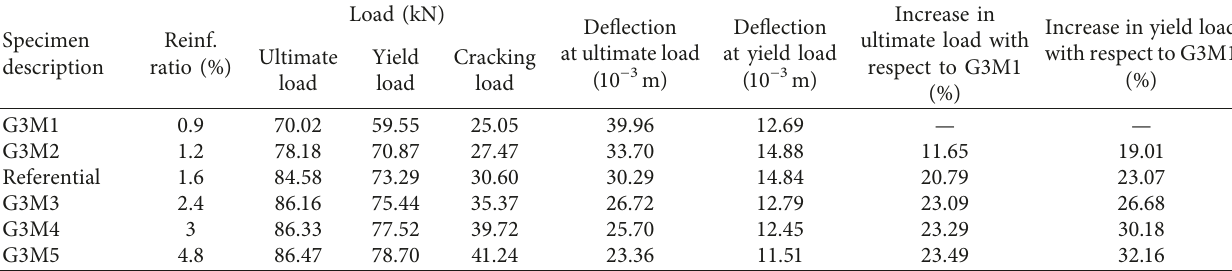
Table 13: Load-deflection response of specimens with different tensile reinforcement ratios.